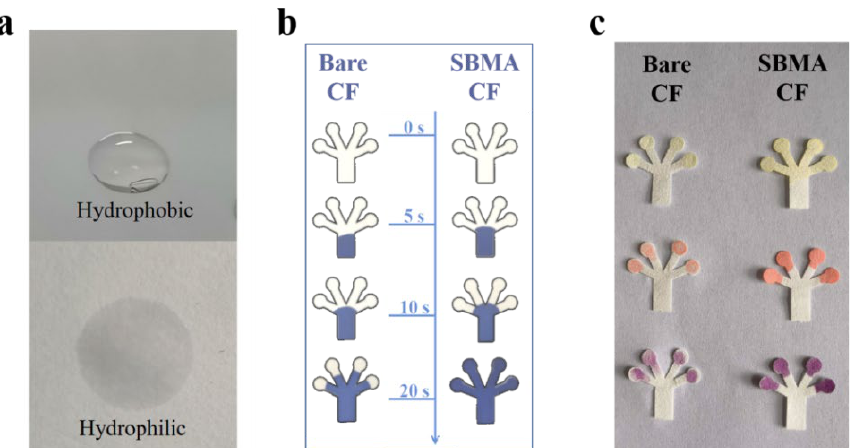
Figure 3. The FT-IR spectra of pSBMA, bare-CF and pSBMA-CF.